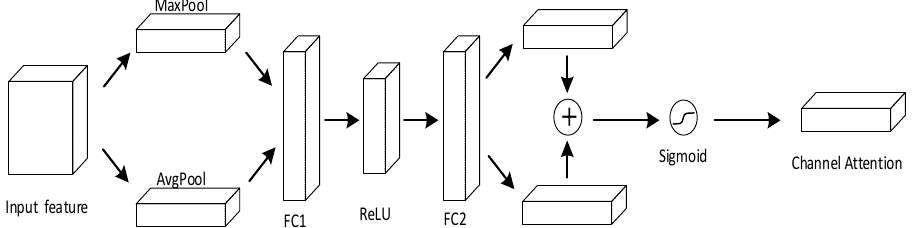
Figure 1. Diagram of channel attention module (CAM). As illustrated, the channel attention module utilizes both max-pooling outputs and average-pooling outputs and forward them to the fully connected layer, which finally generates channel attention through the sigmoid function.